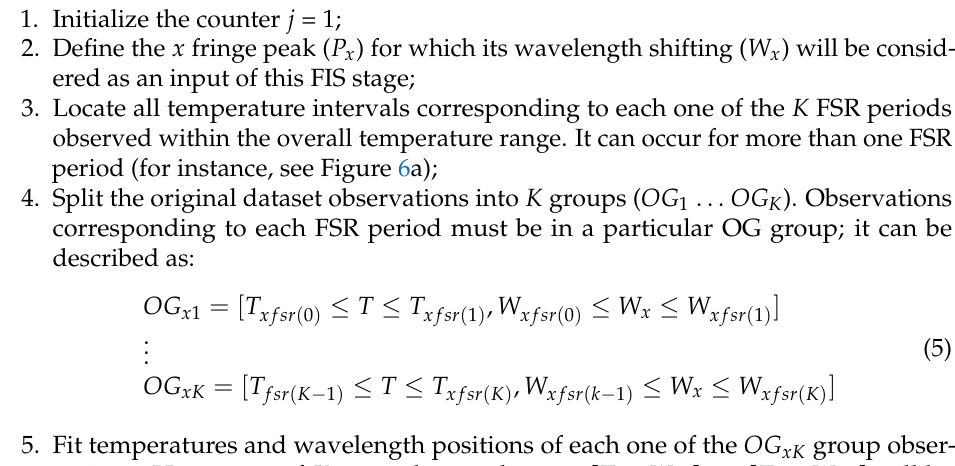
Algorithm 3 Procedure for building the membership functions of